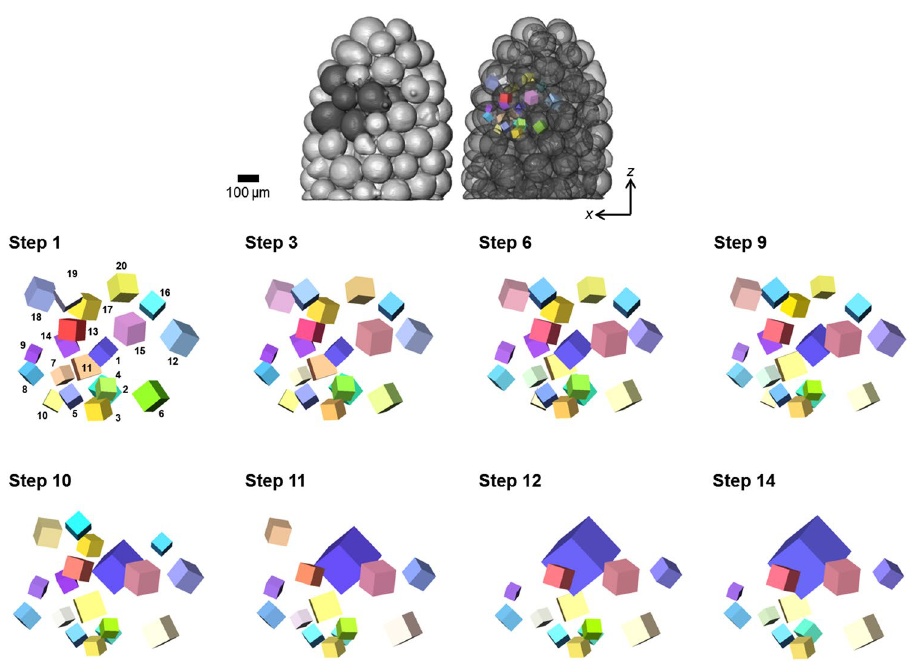
Figure 6. Tracking grains through a time-series of sintering steps. Illustrated above (in dark grey, left image) is a RoI (contains 12 neighbouring particles) in relation to the full sample. Illustrated below is the time evolution of the 20 grains within this RoI, (each numbered in step 1